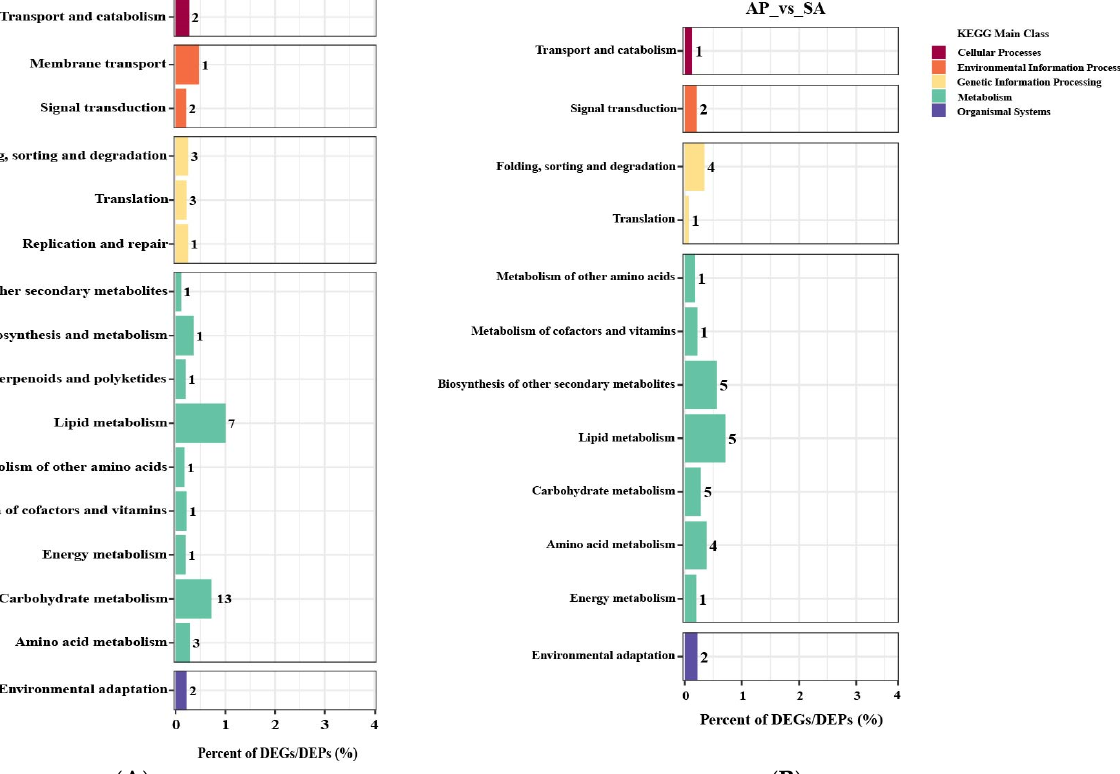
Figure 7. KEGG enrichment analysis of gene and protein association in grafted apricot hybrids. ( A ) Differentially expressed genes (DEGs) and differentially expressed proteins (DEPs) enriched in KEGG pathways in peach/apricot (PA); ( B ) DEGs/DEPs enriched in KEGG pathways in apri- cot/peach (AP).